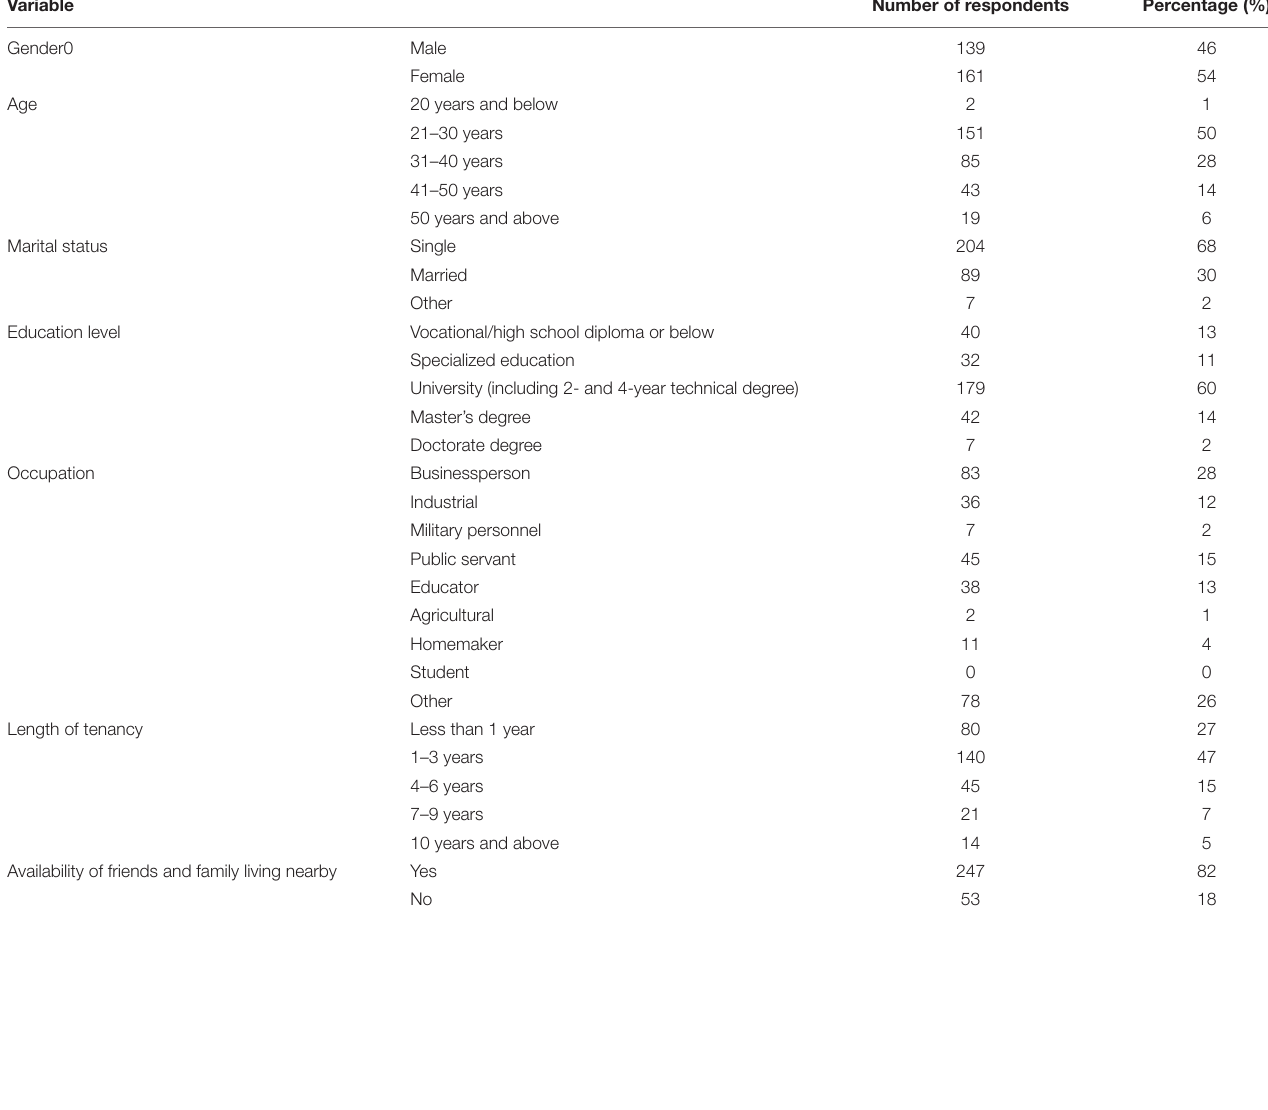
TABLE A1 | Basic data descriptive